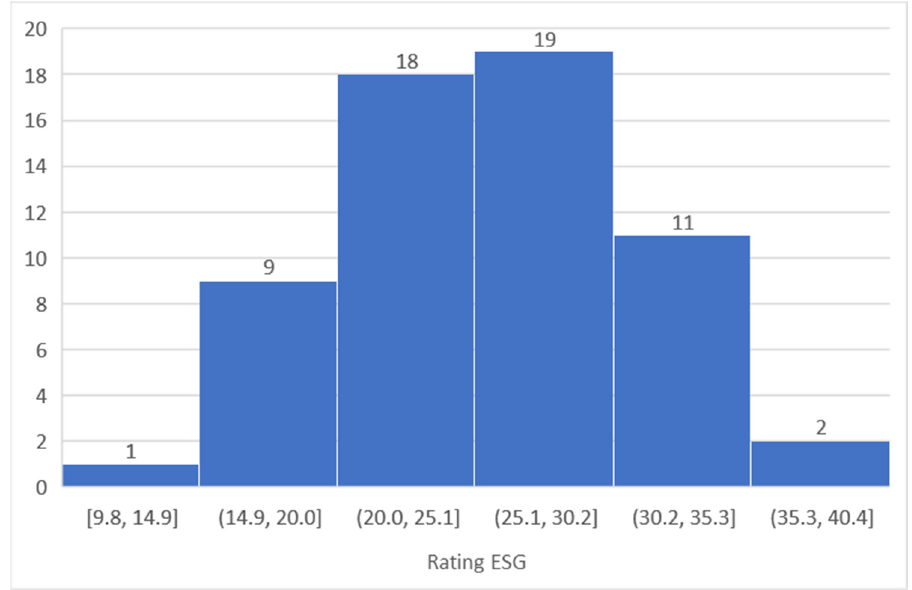
Figure 1. Distribution of the ESG ratings of analysed banks.